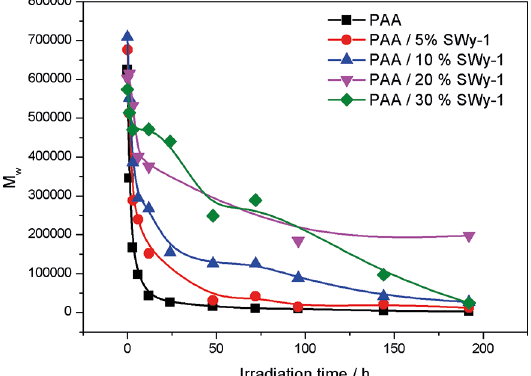
) during photodegradation w